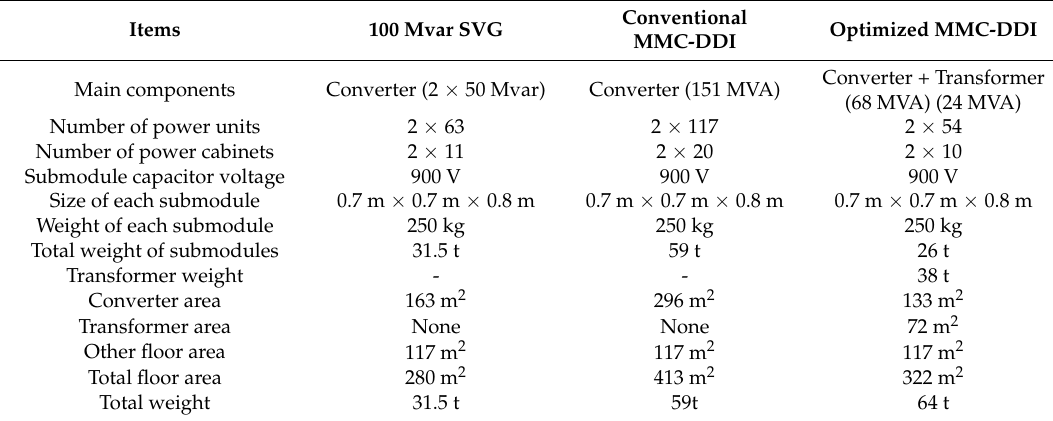
Table 3. Size and weight comparisons of the MMC-DDI under conventional and optimized